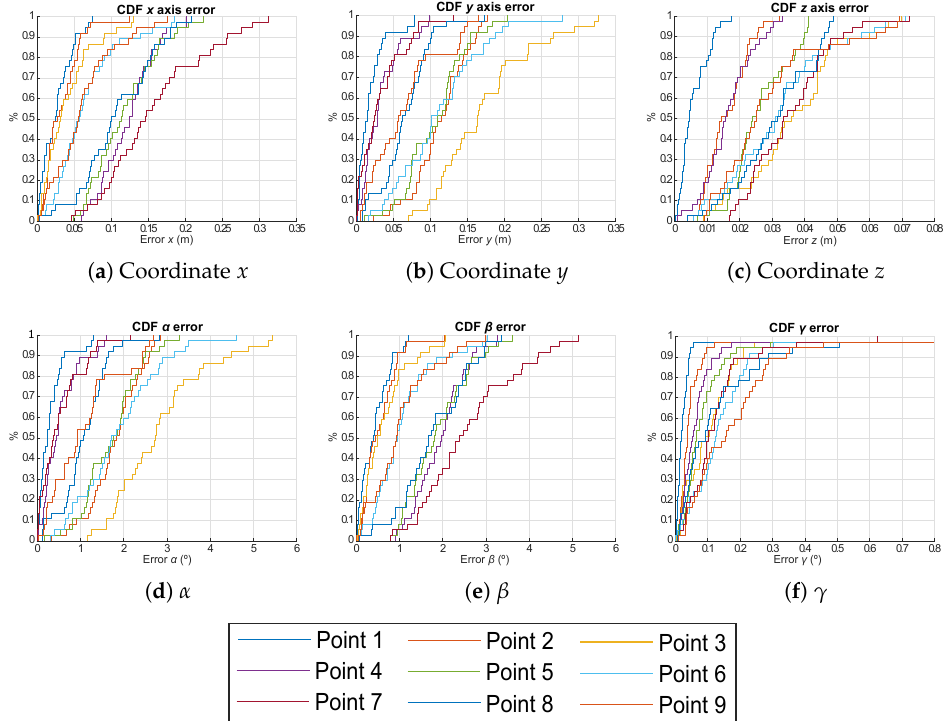
Figure 9. CDF of the absolute pose errors for the nine representative points defined in Table 1 for the case of using the RPnP